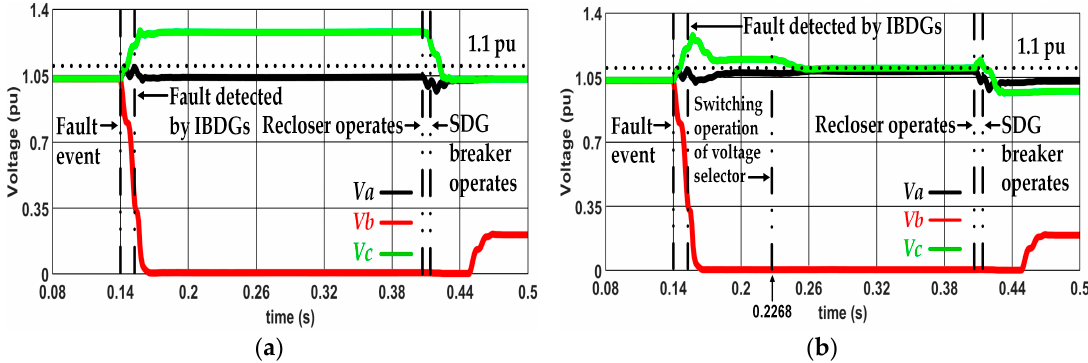
Figure 13. RMS voltage at node 862 during temporary SLG fault: ( a ) disabled voltage regulation feature; ( b ) enabled voltage regulation feature.